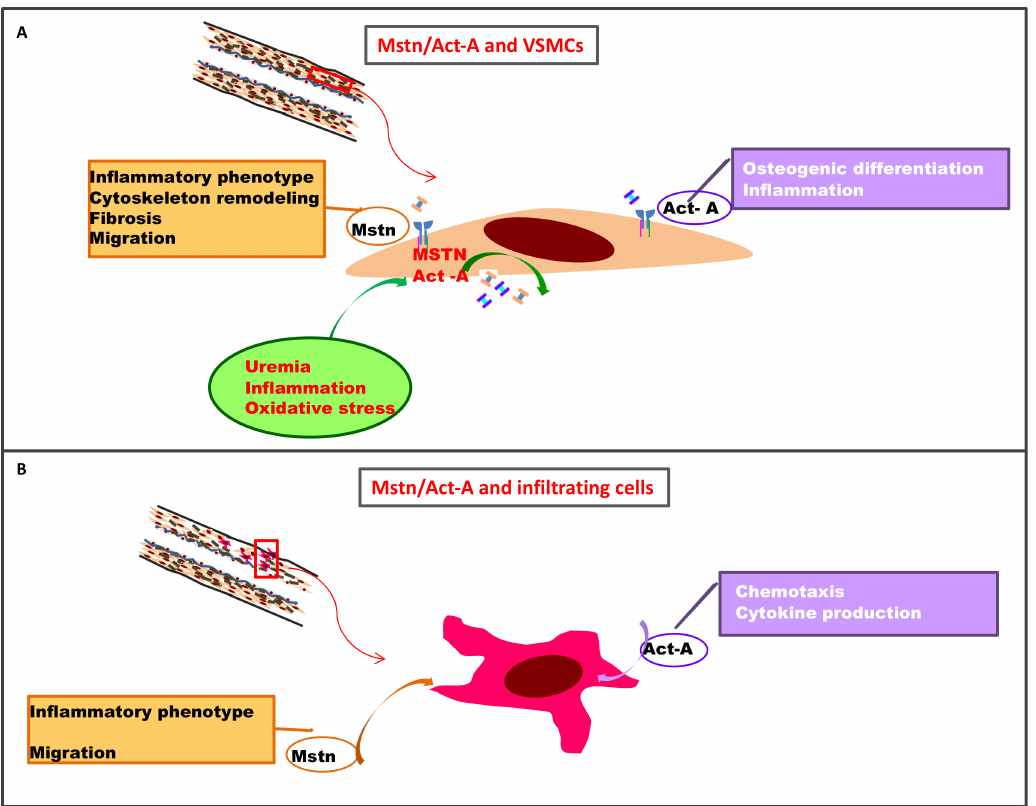
Figure 2. Role of Mstn and Act-A in vascular lesions: ( A ) In VSMCs, uremia, oxidative stress, and inflammation are some of the possible triggers of Mstn and Act-A expression, which could contribute to the atherosclerotic process. Mstn has a salient role in VSMC phenotypic modification, inducing cytoskeleton remodeling, migration, and inflammatory and pro-fibrotic molecule expression. On the other hand, Act-A is more involved with VSMC transformation into osteoblast-like cells responsible for medial calcification; ( B ) In atherosclerotic lesions, Mstn and Act-A infiltrating positive cells (monocytes, macrophages) are present. At that level, Mstn and Act-A may modulate inflammatory response and cell migratory